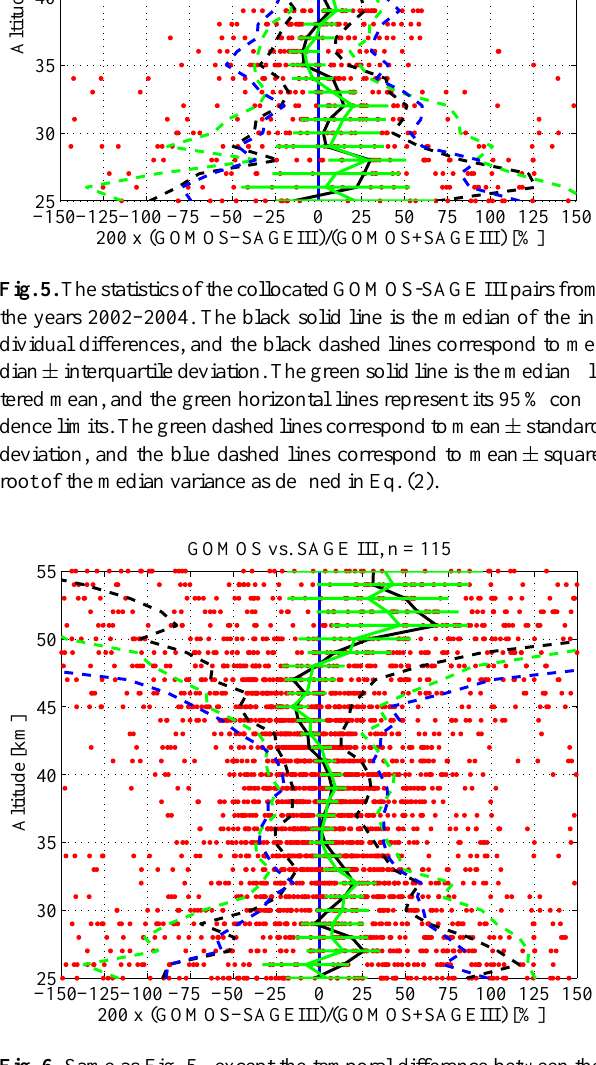
Fig. 6. Same as Fig. 5., except the temporal difference between the measurements is allowed to be as much as one week.